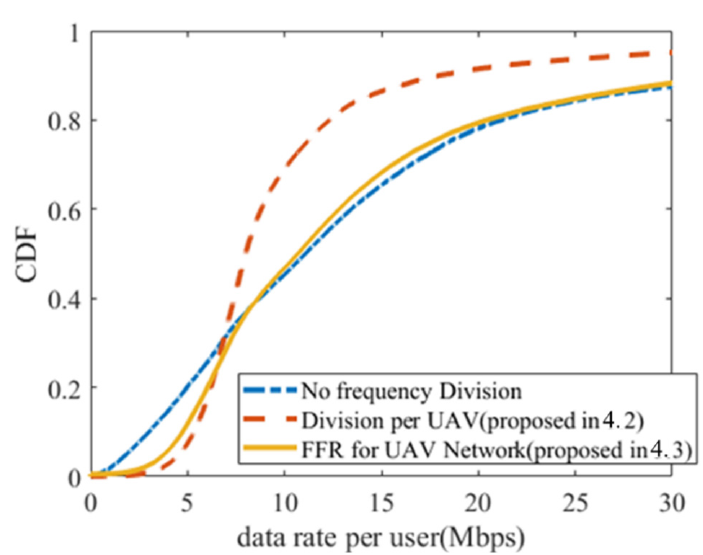
Figure 8. CDF of the data rate for each frequency division method.